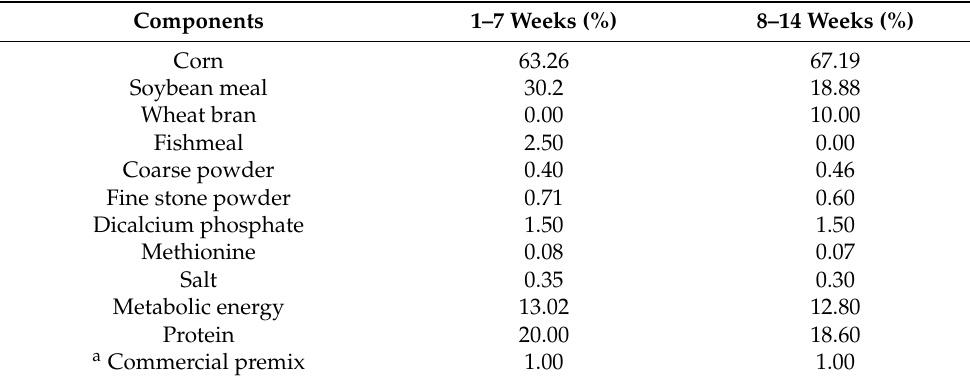
Table 1. Dietary composition and nutrient levels.